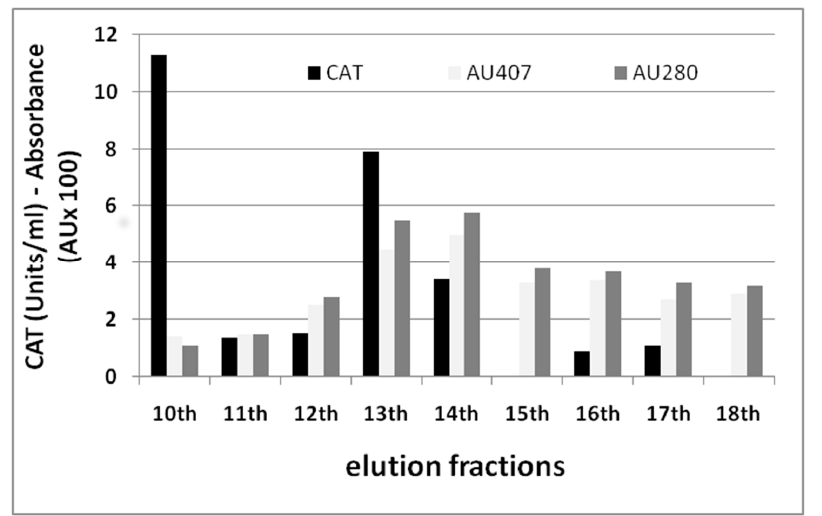
Figure 5. CAT purification from 22% ammonium sulphate precipitates of root cytosolic fractions isolated from resistant tomato cv. Motelle. Precipitates were loaded on a size exclusion column inserted in an automated HPLC system. After void volumes (up to 9th fraction), 1 mL fractions of eluate were collected until they showed detectable CAT, from 10th to 18th fraction. Absorbance